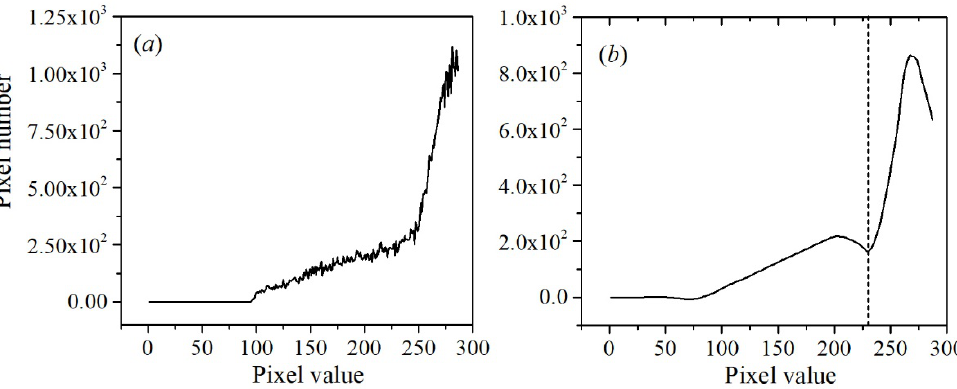
Figure A2. Histograms of grey level image ( a ) and wavelet reconstruction ( b ). The threshold was 231 according to Figure A2b, and all pixels with a value greater than 231 were counted as water in the DWT image.